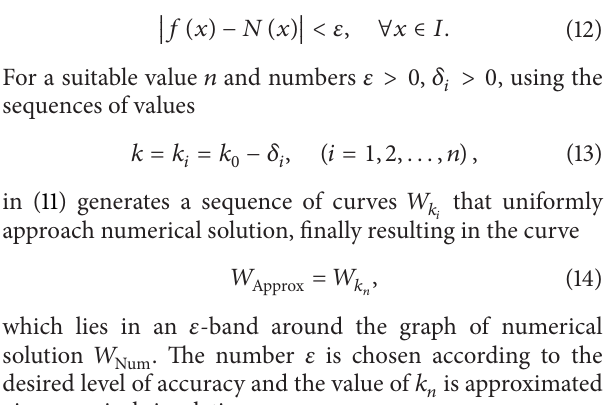
from 1/√0.9 by a small decrement the curves 1− erf (𝑘𝑧) move uniformly towards numerical solution 𝑊